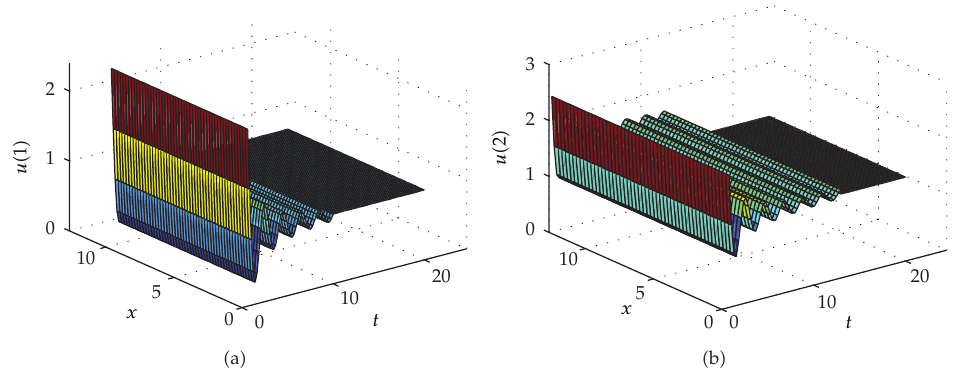
Figure 1: When b (cid:5) 0 . 1, the positive equilibrium point Y 0 is asymptotically